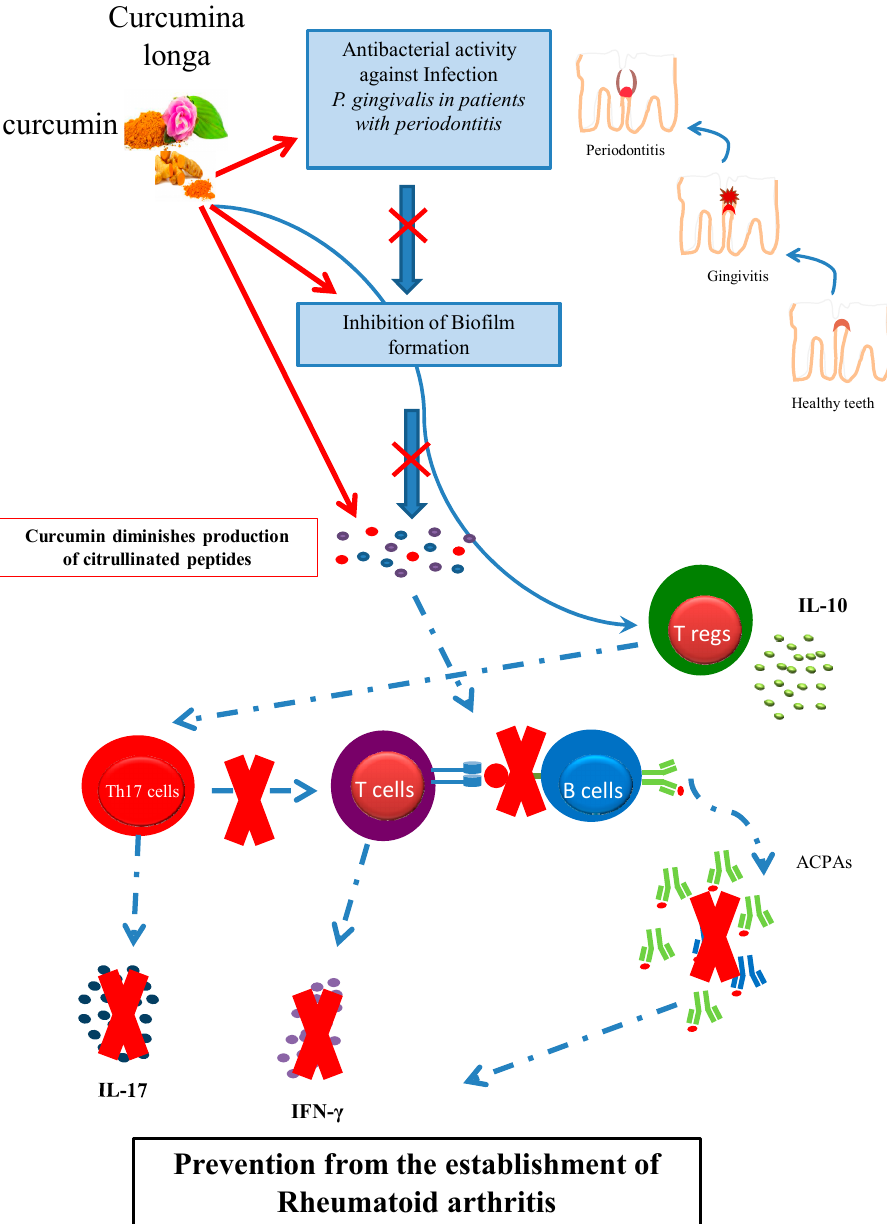
Figure 1. Curcumin may play a significant role in preventing from rheumatoid arthritis through its antibacterial action against P. gingivalis infection and biofilm formation in patients with periodontitis; and modulation of the proinflammatory immune response, such as inhibition of Th17 cells and enhancement of IL-10 producing regulatory T cells.